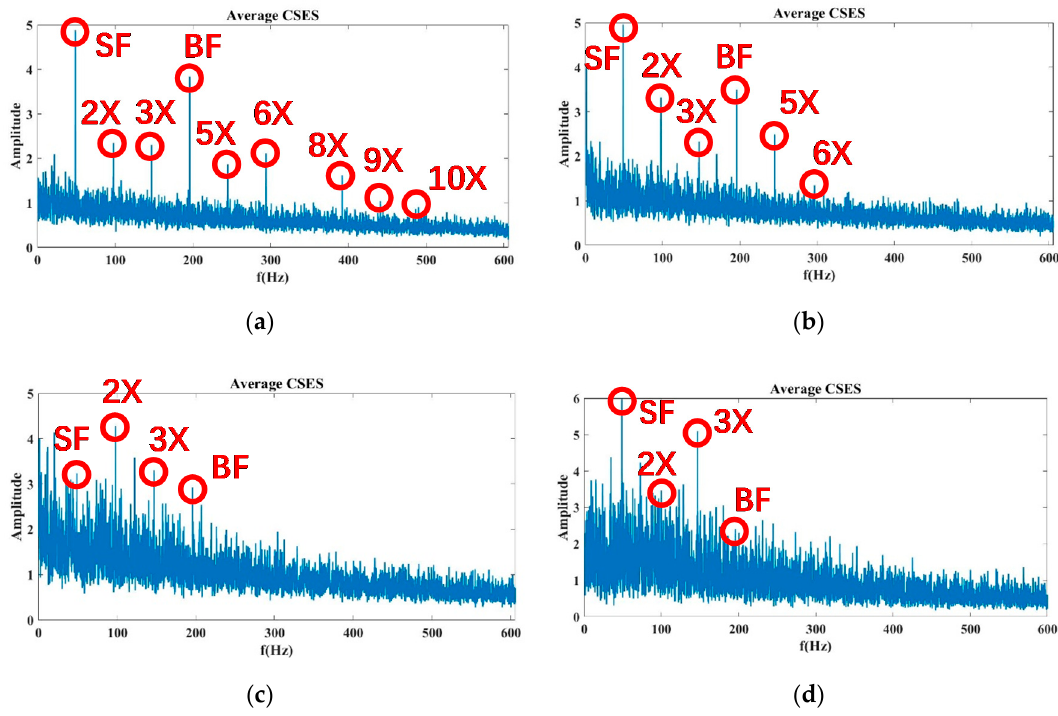
Figure 11. Average CSES spectrum of the Autogram at a 100% flow rate for Sensor 15: ( a ) Status 1: No cavitation; ( b ) Status 8: Incipient cavitation; ( c ) Status 9: Severe cavitation; ( d ) Status 10: Very severe cavitation.